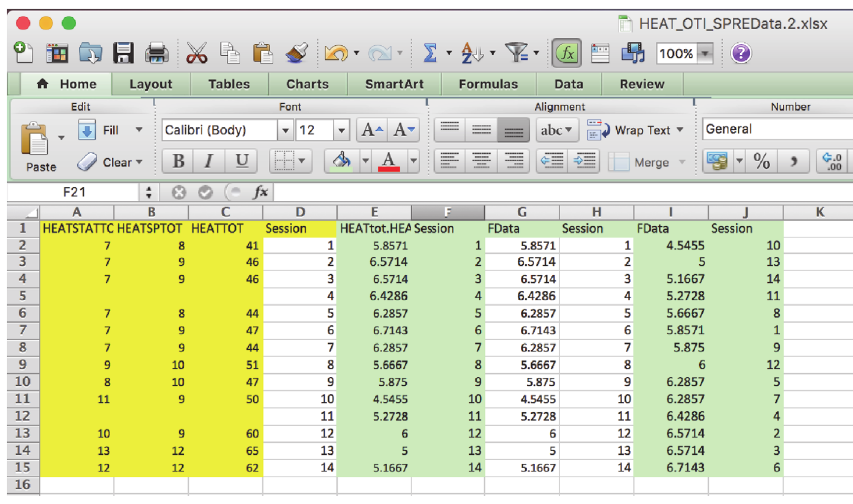
Figure 1: Excel (CSV) data for static posture of Partic.c for SPRE from raw data to arranged